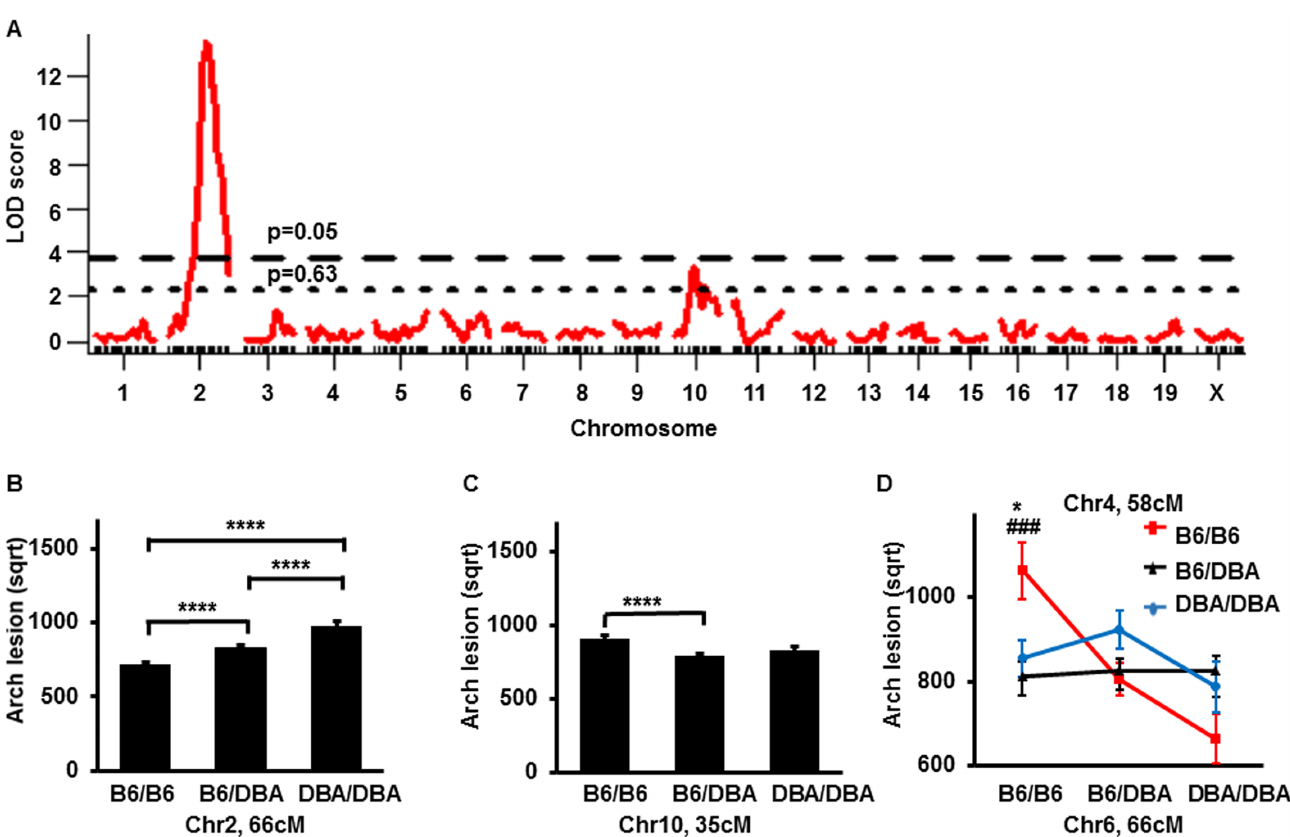
Fig 1. LOD curves and allelic distribution of QTLs for arch plaque lesion. (A) LOD curve for arch lesion size with sex as additivecovariatein F2 mice from a cross B6-apoEx DBA-apoE. The horizontaldashedline represents a threshold for a suggestive(p = 0.63) QTL and a dotted line represents a threshold for a significantQTL (p = 0.05). The significancethresholds for LOD scores were determinedby 1000 permutations using R/qtl software. (B) Allelic distributionof the QTL on Chr2 for plaquelesion size at the arch at the nearest marker to the peak in F2 mice from the cross B6-apoEx DBA-apoE. Data represent mean ± SE. Lesionsize comparisonwas performed by one-way analysisof variance (ANOVA) (p < 0.0001) followedby Tukey-Kramer’s HSD-test. **** p < 0.0001(C) Allelic distribution of QTL on Chr10 for plaquelesion size at the arch at the nearest marker to the peak in F2 mice from the cross B6-apoEx DBA-apoE. Data represent mean ± SE. Lesion size comparisonwas performed by one-wayanalysisof variance (ANOVA) (p < 0.001)followedby Tukey-Kramer’s HSD-test. p = 0.06 betweenB6/B6 and DBA/DBA genotypes, **** p < 0.0001betweenB6/ B6 and B6/DBA genotypes (D) Allelic distributionof the main effect QTL for plaquelesion size at the arch in Chr 4 and Chr 6 in both sexes in F2 mice from the cross B6-apoEx DBA-apoE. Data represent mean ± SE. Only mice homozygousfor B6 alleleat both Chr4 and Chr6 have increasedplaque size by one-wayANOVA (p = 0.001), followedby Tukey-Kramer’s HSD-test: * p < 0.05-B6/B6 genotypevs DBA/DBA genotype, ### p < 0.001-B6/B6 genotypevs B6/DBA